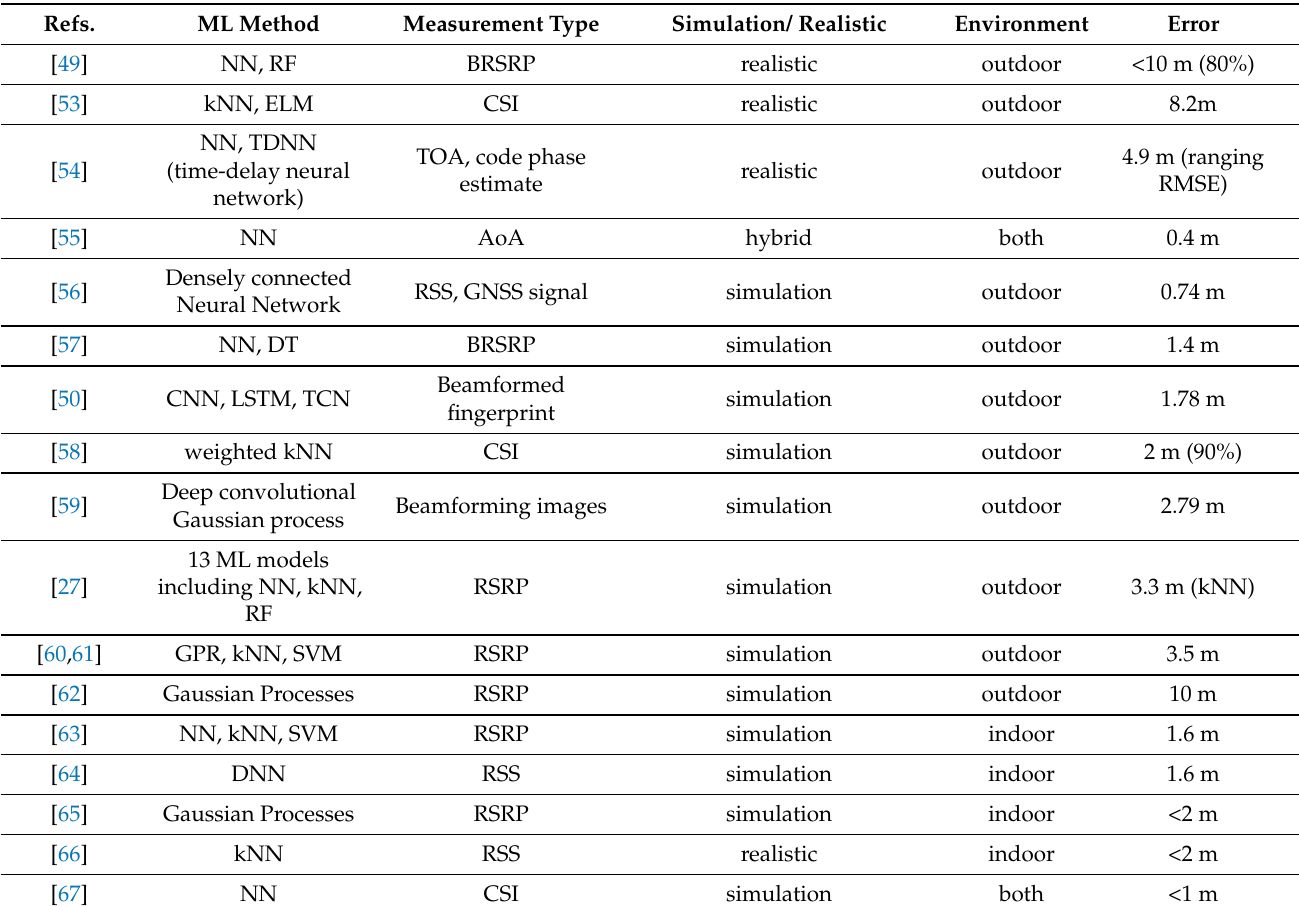
Table 2. Comparison of the machine-learning-aided positioning techniques in 5G networks.